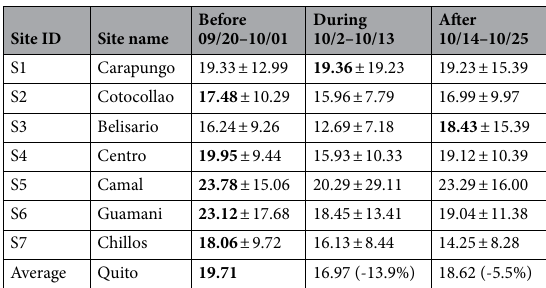
Table 1. Average PM 2.5 concentration (µg m −3 ) change before (September 25–October 1), during (October 2–13) and after (October 14–25) the national 2019 strike in seven monitoring sites in Quito, Ecuador. The biggest values out of the three periods are marked in bold font.